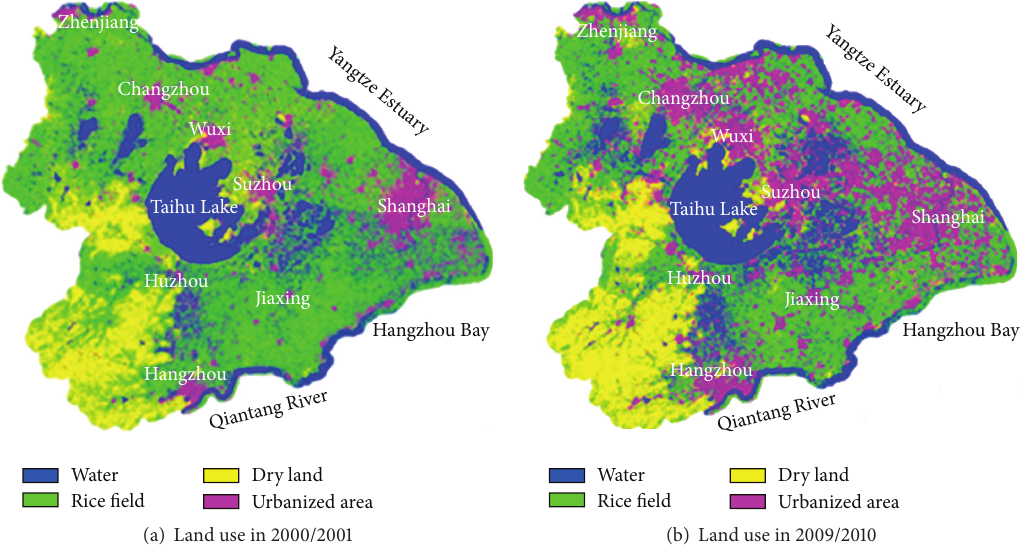
Figure 2: Changes in land use types from 2000 to 2010 in the Taihu Basin